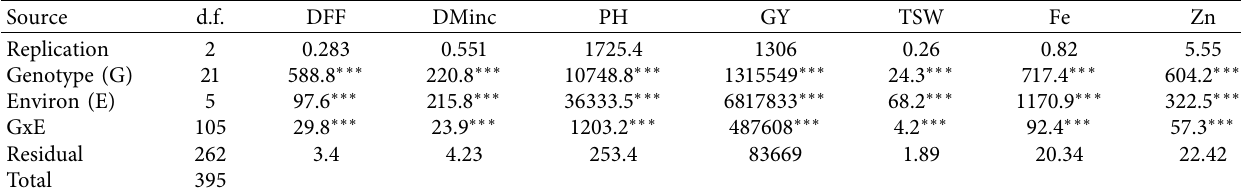
Table 4: Combined analysis of variance for nine traits of 22 pearl millet OPV genotypes evaluated in two locations for three seasons in Ghana.